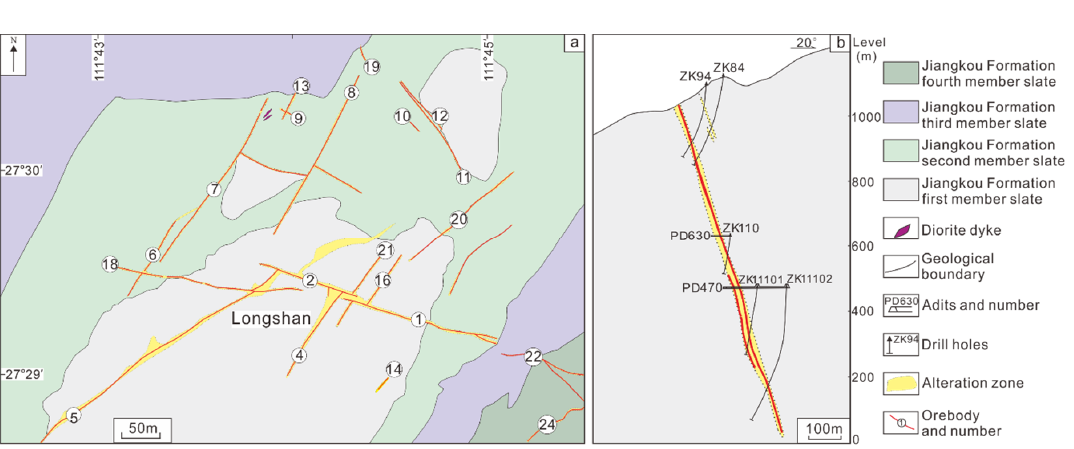
Figure 2. Simplified geological map of Longshan dome, South China (modified after Chen et al. [52]). The Longshan Sb-Au deposit (3.7 Mt @4.5 wt. % Sb and 4.6 g/t Au, [53]) contains two mining zones: Longshan and Xiejiashan (Figure 2). These include 27 NE-striking, NWW-striking and NNE- striking vein groups. The No.1 and No.2 vein groups (Figure 3a), which are the largest ore bodies, occur as a steeply NWW-striking and NE-dipping (65–80°) body within metamorphic slates. It is more than 1400 m long and 0.2 to 1.3 m wide and continues for 1050 m down-dip, with an average grade of 0.77 to 6.79 wt. % Sb and 0.3 to 4.6 g/t Au.